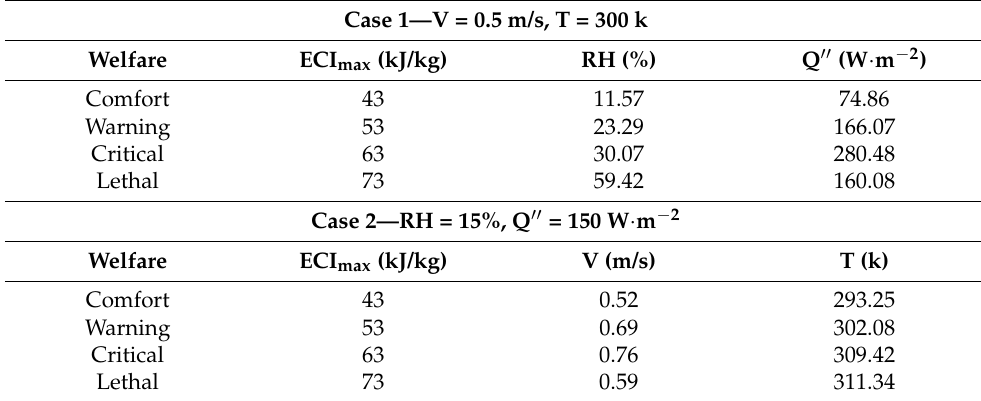
Table 4. Results of BO inverse mapping to estimate input parameters for various ECI max ( kJ/kg )